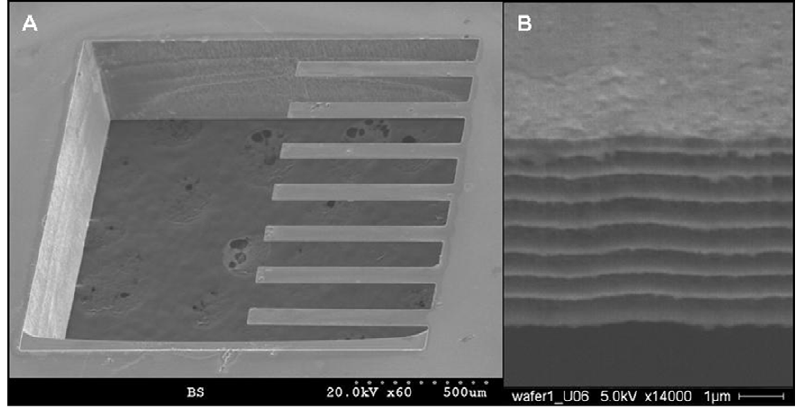
Figure 2. SEM micrographs of silicon cantilevers. A) Low magnification (60x) micrograph of cantilever array. B) High magnification (14000x) image used to measure the thickness of the cantilever. Both images were taken at 50 u from normal.